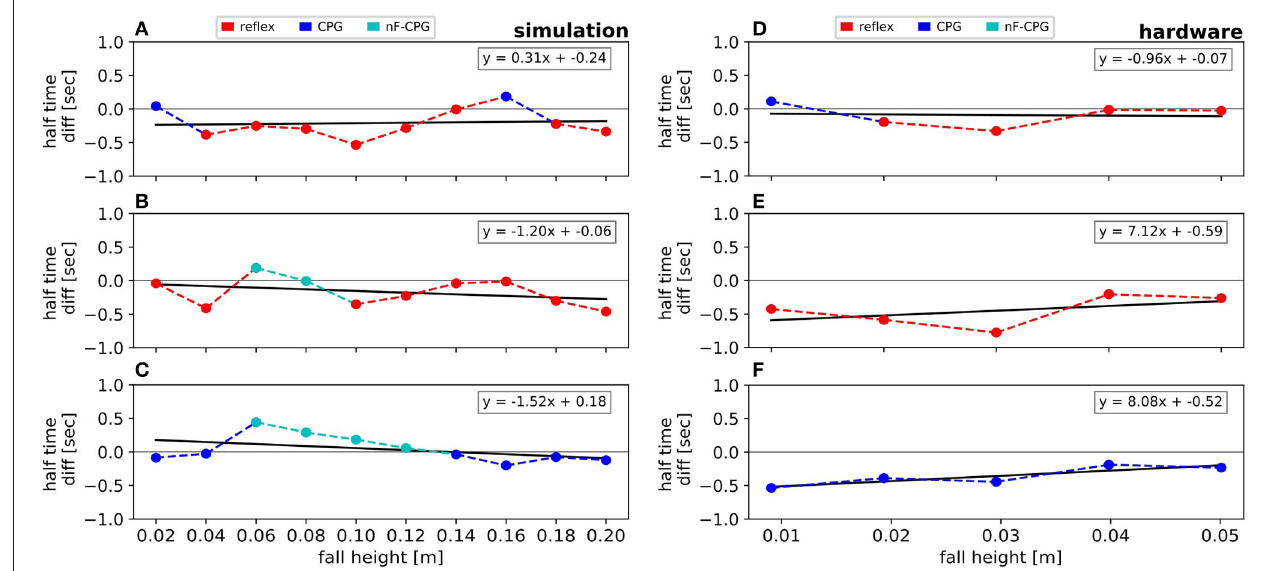
FIGURE 5 | Visualization of the half-life time differences between the reflex, the adaptive CPG and the pure (no feedback) CPG as stated in Table 2 . Results are shown for the simulation (A–C) and the hardware experiments (D–F) . The half-life times are individually compared for the reflex vs. the adaptive CPG (A,D) , the reflex vs. the pure CPG (B,E) and the adaptive CPG vs. the pure CPG (C,F) . The colors are chosen according to which controller was faster in each condition. For every comparison a curve is fitted to investigate the trend.